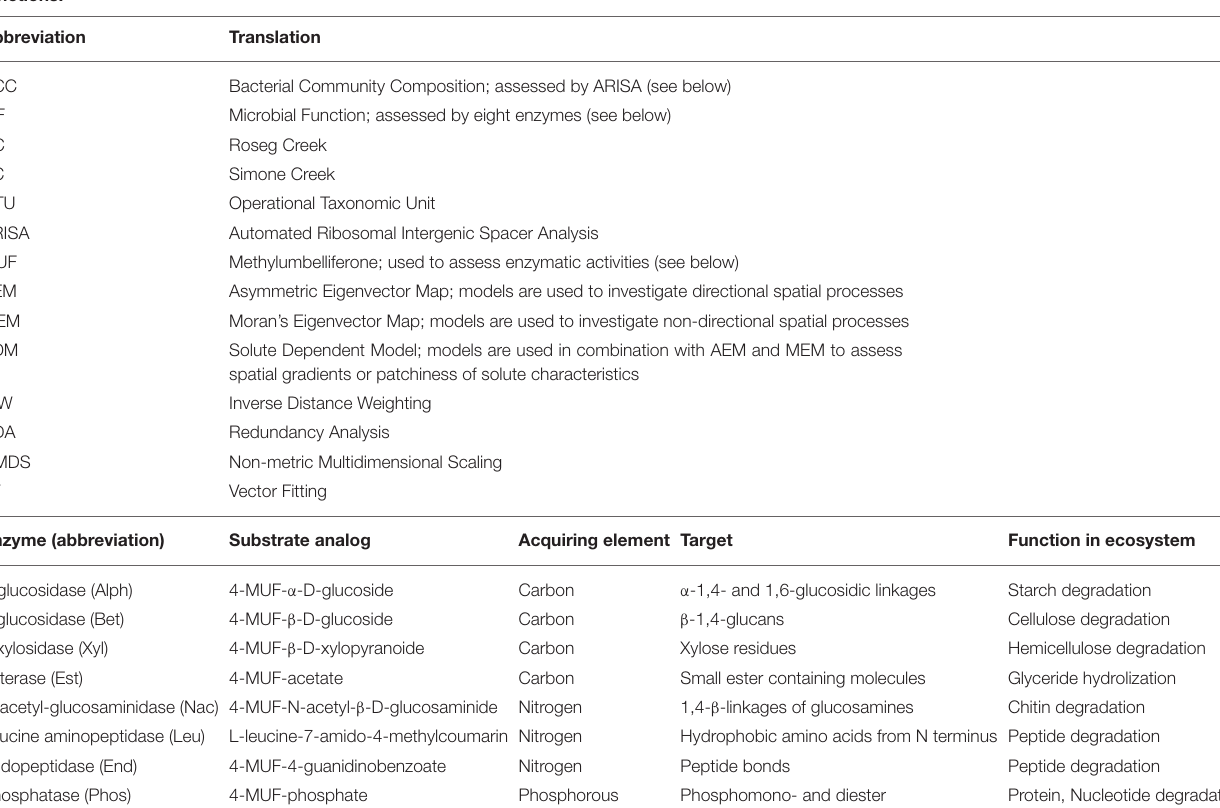
TABLE 1 | Abbreviations and translations used in the manuscript and enzymes analyzed in this study, substrate used for assays and their biogeochemical